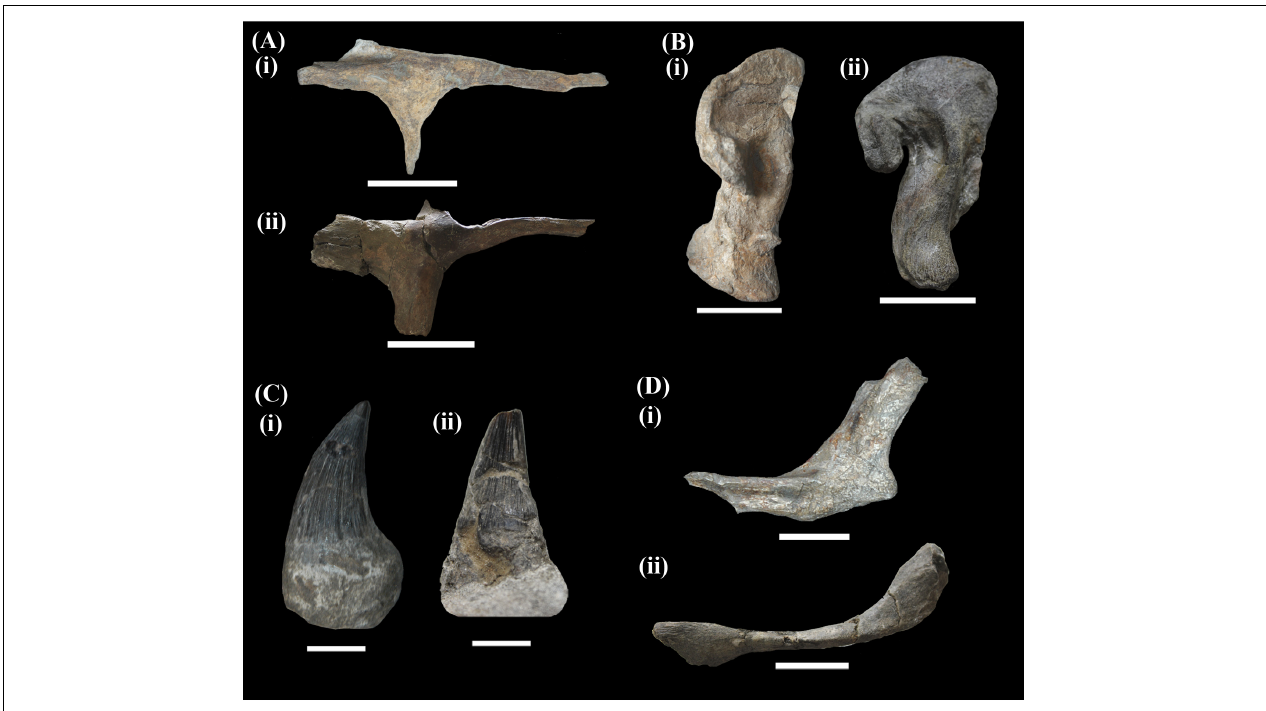
FIGURE 8 | Comparison of cranial elements of Taniwhasaurus . (A) Postorbitofrontal: (i) Ta. oweni KHM N99-1014/1-5; (ii) Ta. antarcticus IAA 2000-JR-FSM-1. Scale bars equal to 50 mm; (B) quadrate: (i) Ta. oweni KHM N99-1014/1-5; (ii) Ta. antarcticus IAA 2000-JR-FSM-1. Scale bars equal to 50 mm; (C) teeth: (i) Ta. oweni KHM N99-1014/1-5; (ii) , Ta. antarcticus IAA 2000-JR-FSM-1. Scale bars equal to 20 mm; (D) jugal: (i) Ta. oweni KHM N99-1014/1-5; (ii) Ta. antarcticus IAA 2000-JR-FSM-1. Scale bars equal to 50 mm.